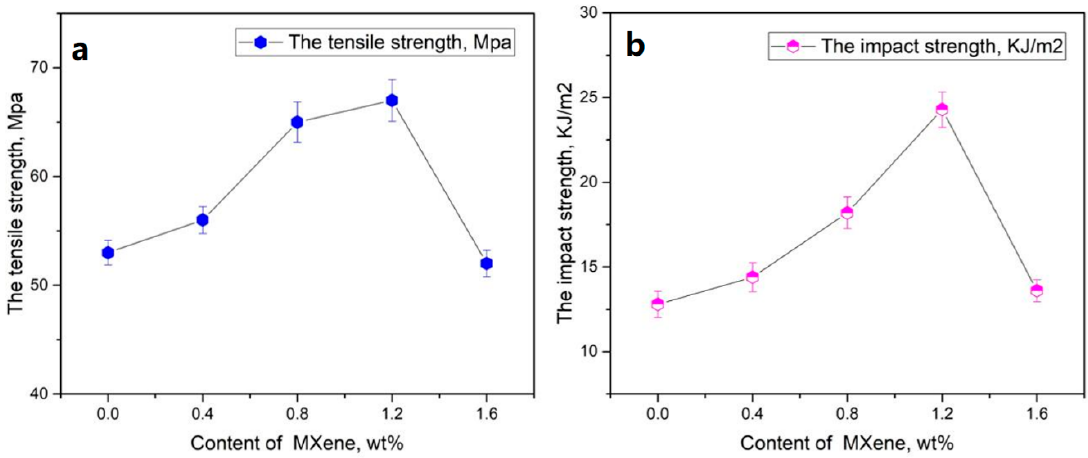
Figure 8. The ( a ) tensile strength and ( b ) impact strength of the EP / Ti 3 C 2 T x MXene nanosheets Figure 8. The tensile strength and impact strength of the EP/Ti 3 C 2 T x MXene nanosheets composite composite under various contents of the Ti 3 C 2 T x MXene under various contents of the Ti 3 C 2 T x MXene nanosheets.